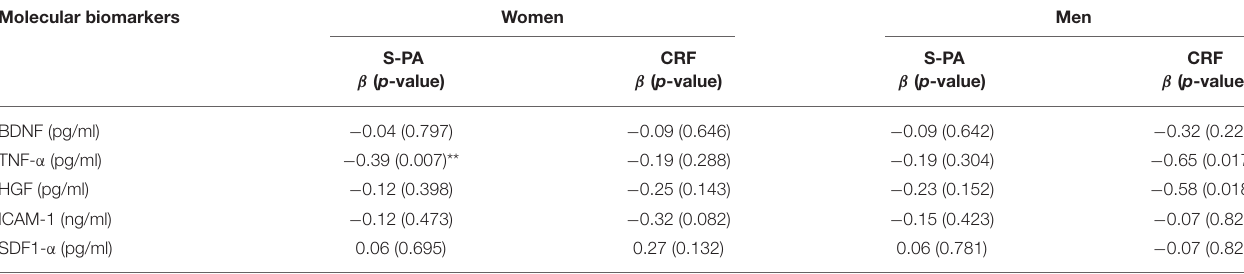
TABLE 2 | Linear regression models in women and men: relationship between physical activity variables and molecular biomarkers. Molecular biomarkers